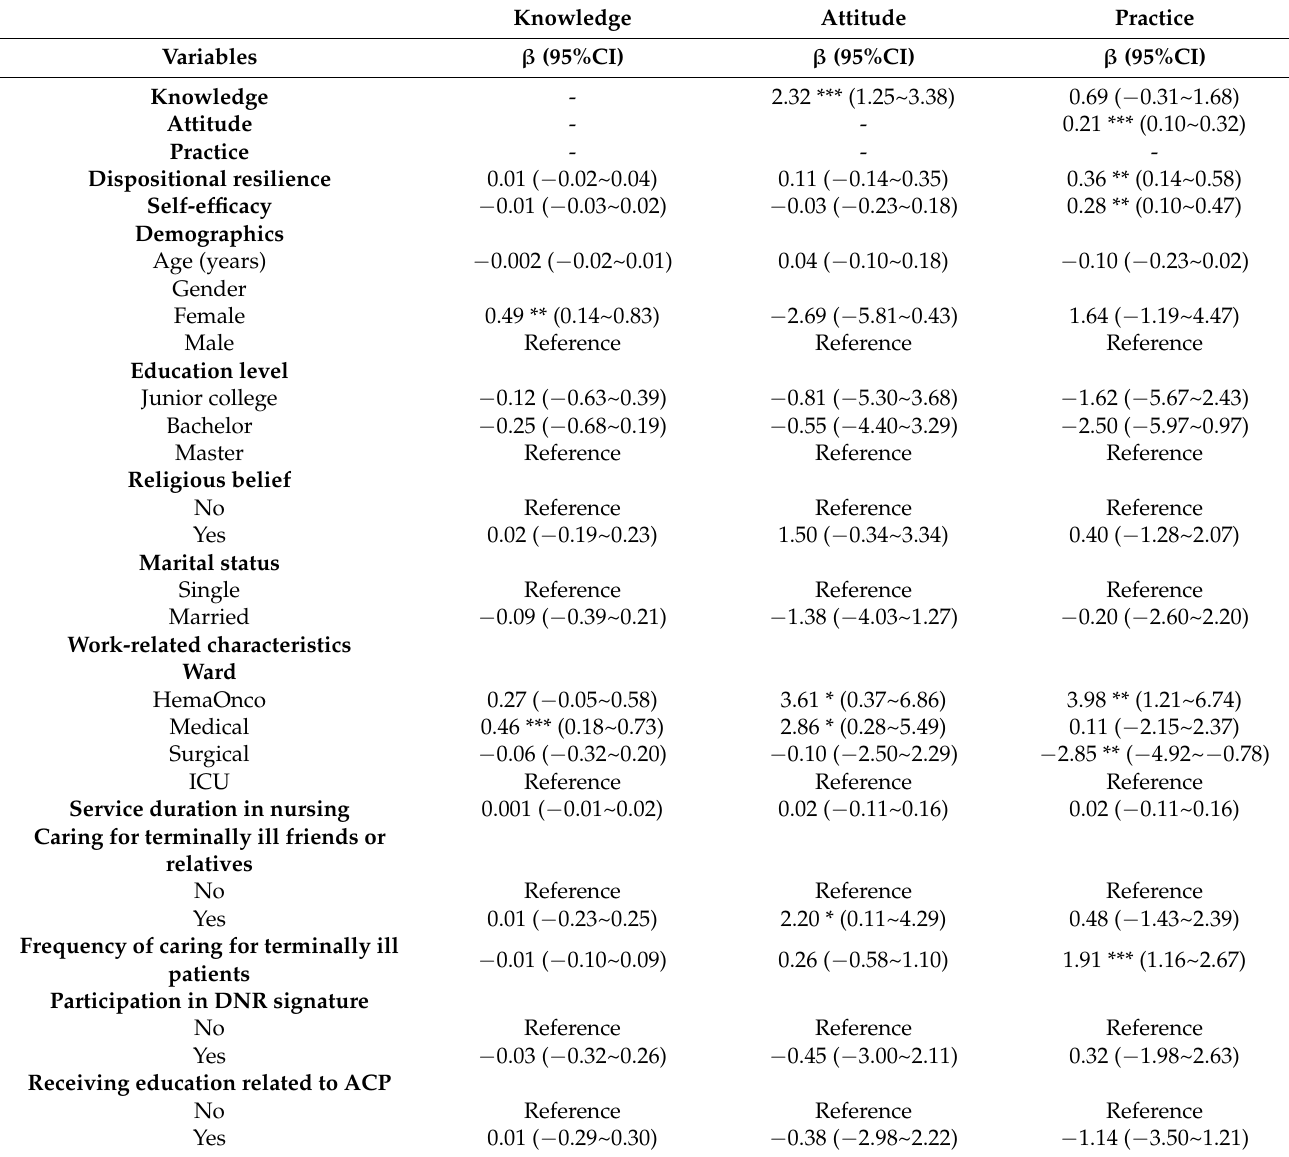
Table 3. Predictors of knowledge, attitude, and practice of ACP of terminally ill patients among nurses (N =